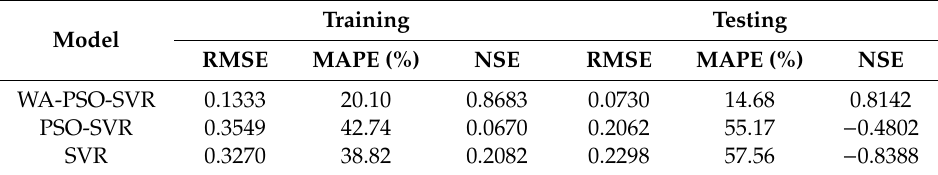
Table 6. Statistical values of monthly NH 3 -N prediction in the training and testing phase. Model